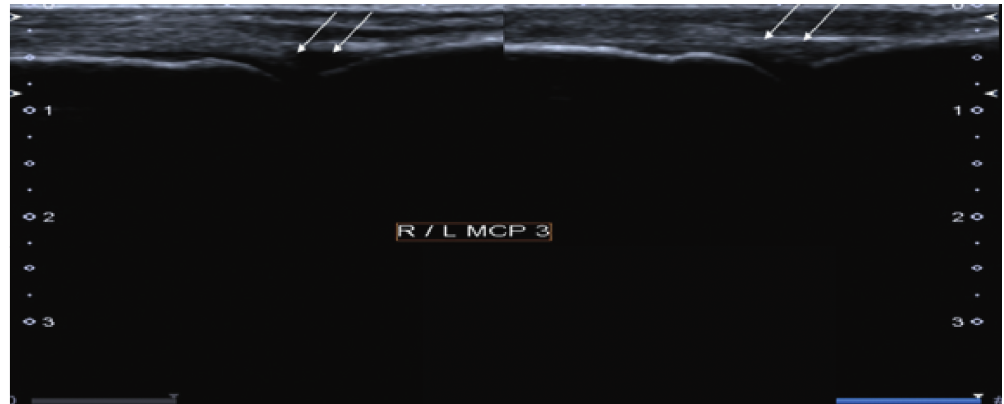
Figure 4: Grayscale images of bilateral 3 rd metacarpophalangeal joint demonstrating moderate synovial thickening (white arrows). The findings are consistent with Grade 2